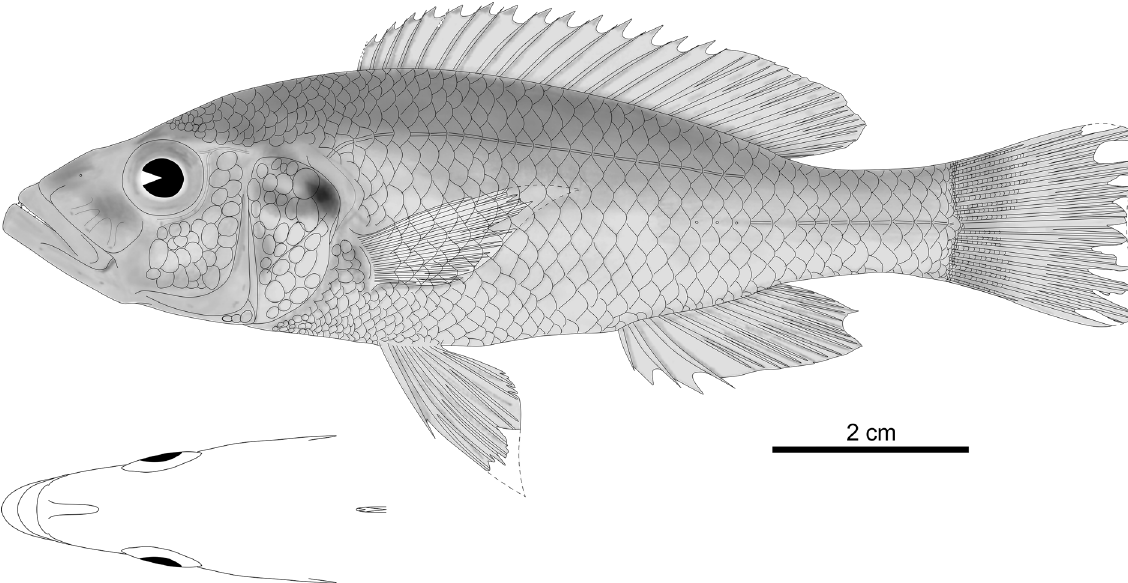
Fig. 8. Haplochromis mentatus Regan, 1925, holotype, ♀, 93.1 mm SL (MCZ 31523) reconstructed with a straightened vertebral column. Drawn by N.